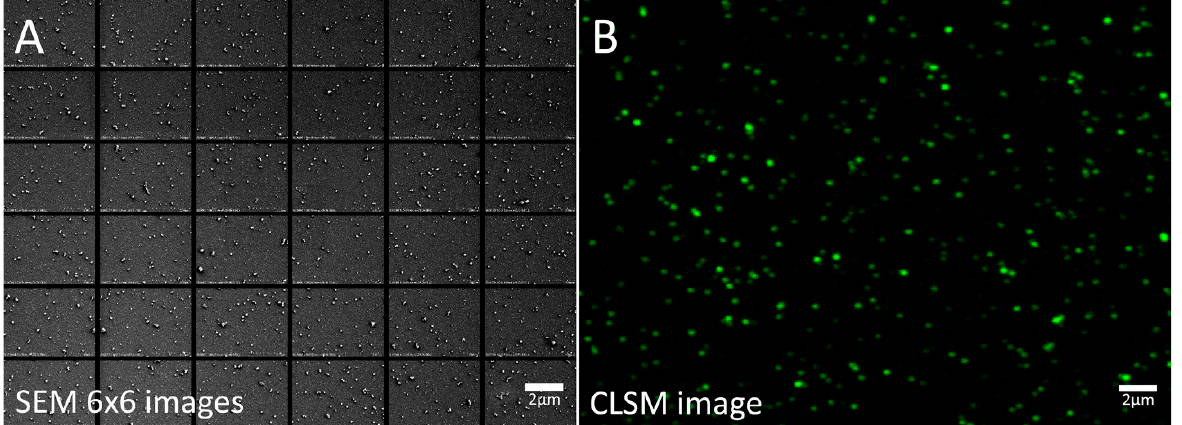
Figure 4. SEM and CLSM images viewed at the same scale of two different regions SARS-CoV-2- infected cell culture supernatants after 25XConA coating and centrifugation. ( A ): SEM 6 × 6 mosaic 1280 × 960 pixel images at x25k magnification. ( B ): Zoom-in on a single 512 × 512 pixel CLSM image of Alexa-488 fluorescence signal after anti-SARS-CoV-2 staining at ×63 magnification, zoom 2.4.